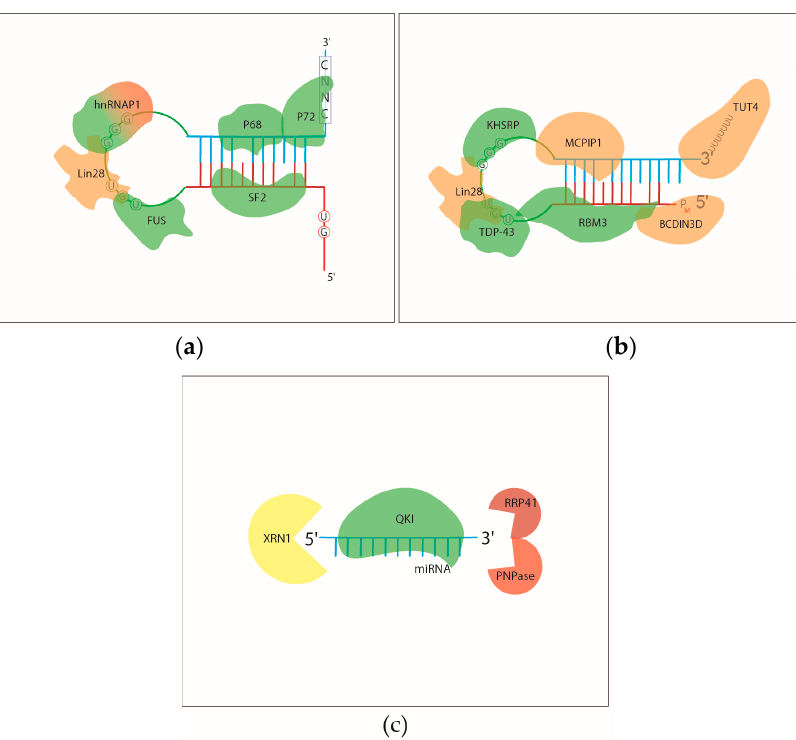
Figure 2. RNA binding proteins that regulate ( a ) pri-miRNAs and ( b ) pre-miRNAs biogenesis by recognizing sequences or structures on the hairpin RNA. RBPs labeled with green are promoting miRNA processing and PBPs coloured with orange are inhibitors of the miRNA pathway; ( c ) RBPs that regulate the stability and turnover of mature miRNAs.